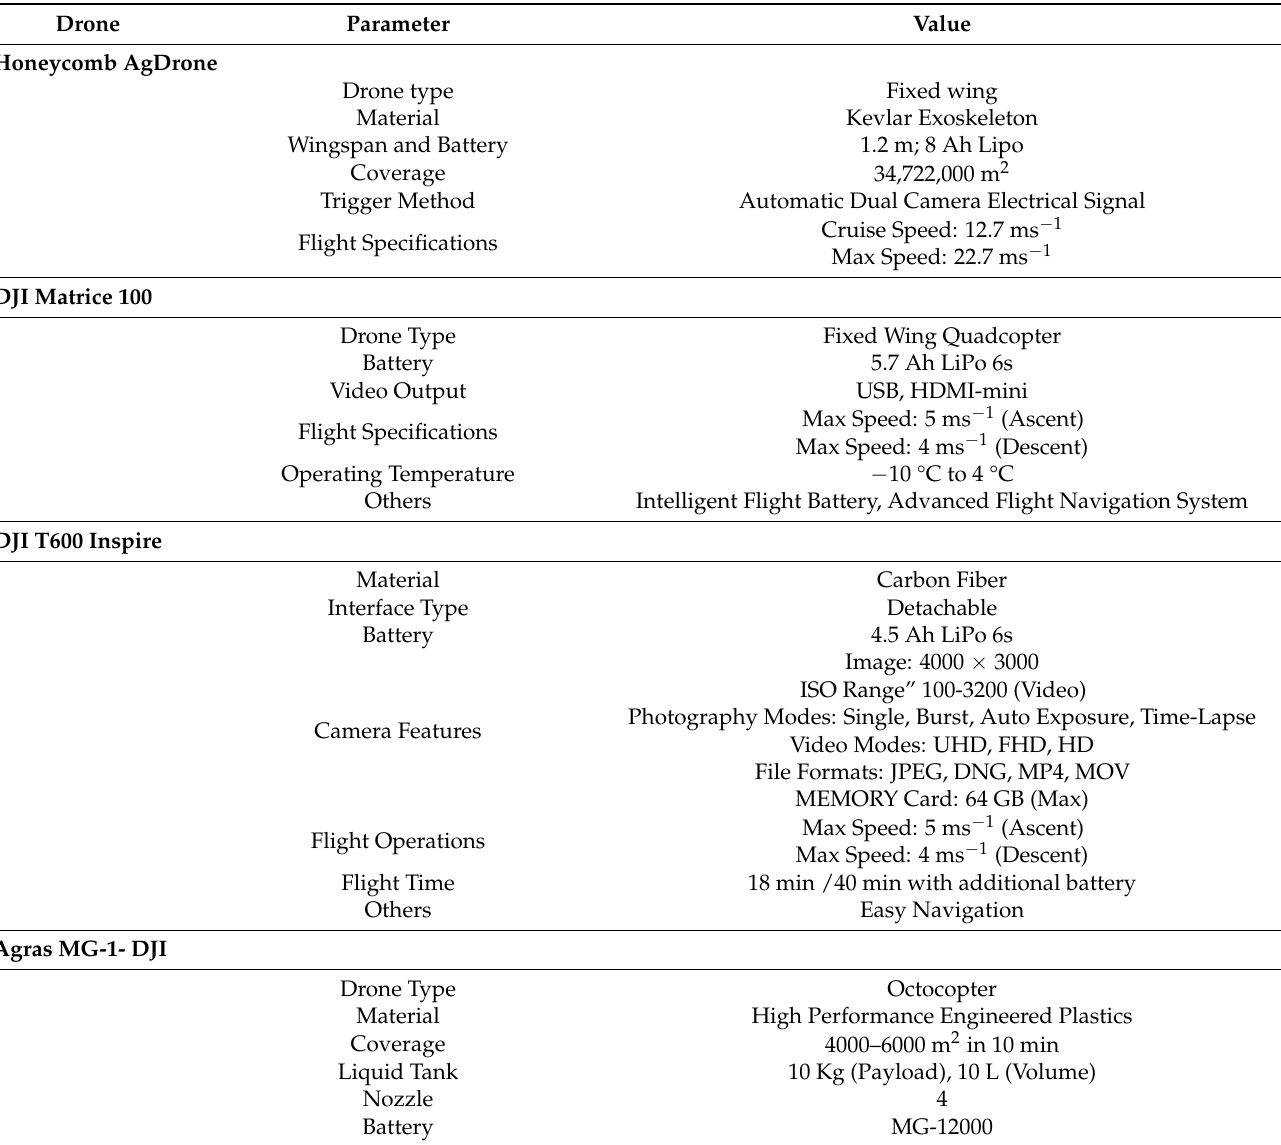
Table 1. Characteristics of a few drones applied in agriculture field